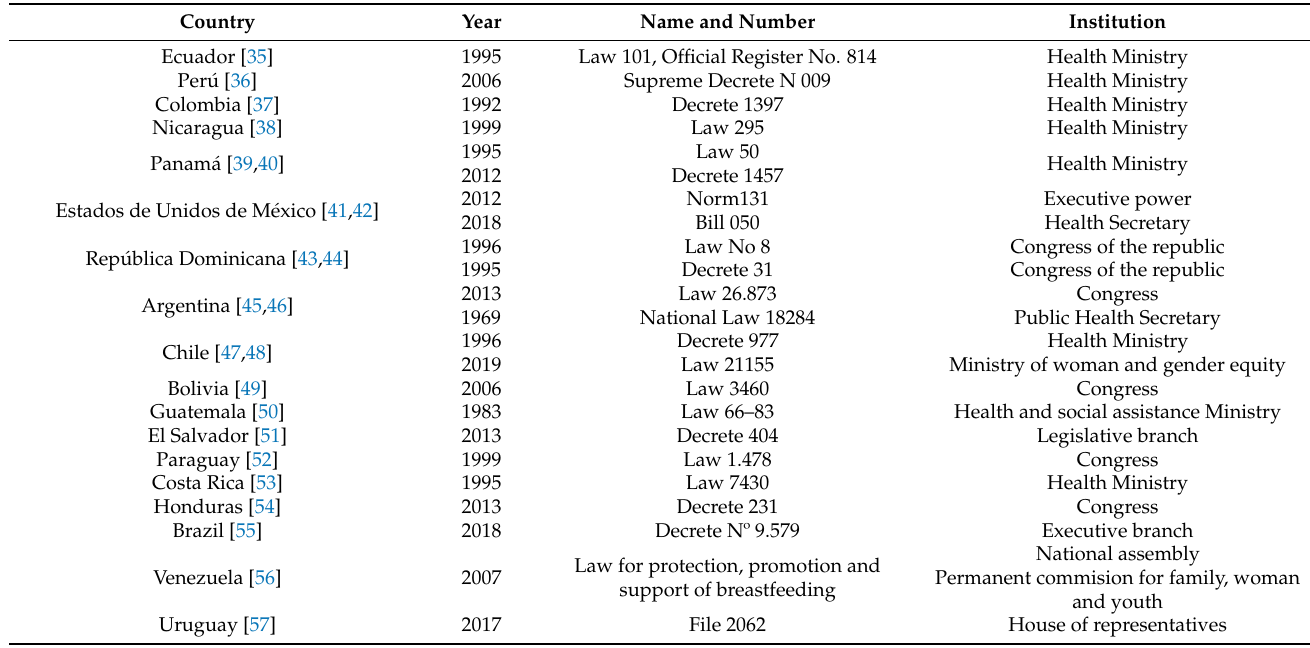
Table 6. Regulations on BMS in Latin American